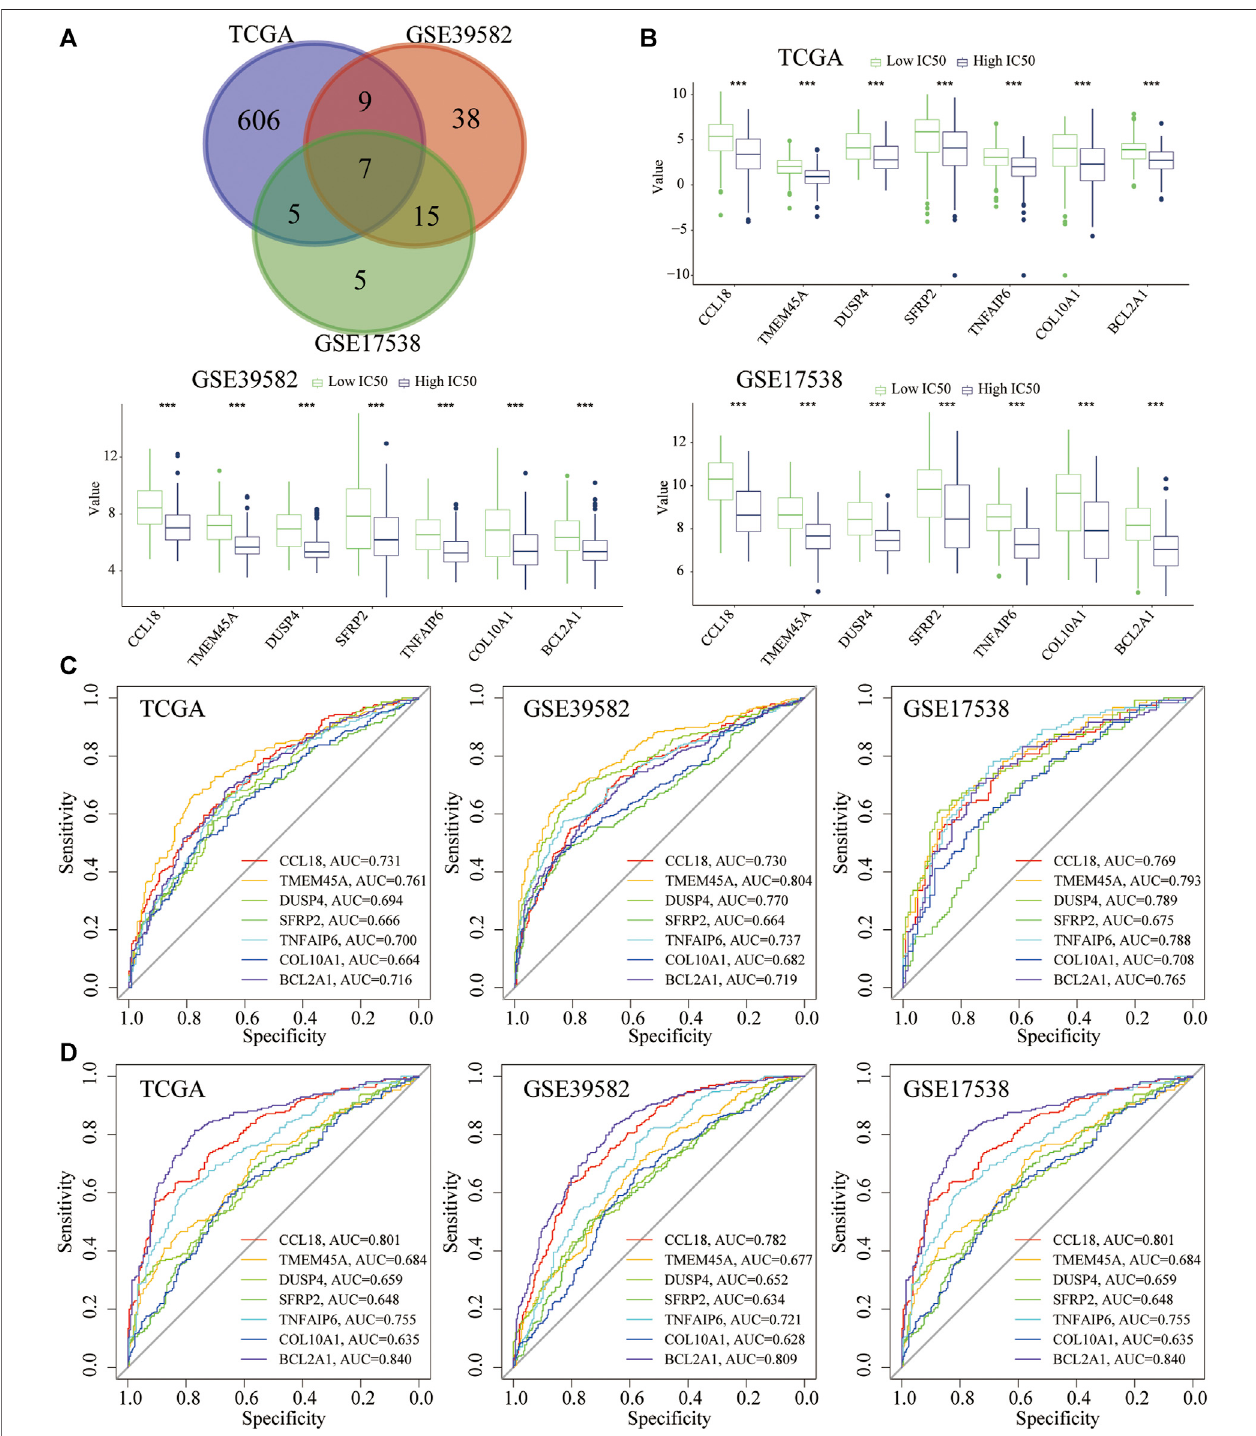
FIGURE 5 | DEGs related to cisplatin resistance and their diagnostic performance. (A) The seven shared DEGs (High vs. low IC50). (B) The seven shared genes weresigni fi cantlyoverexpressedinthelow-IC50group. (C) Diagnosticperformance(highorlowIC50)ofsevengenes. (D) Diagnosticperformance(highorlowPD-L1)of seven genes. *** p < .001.